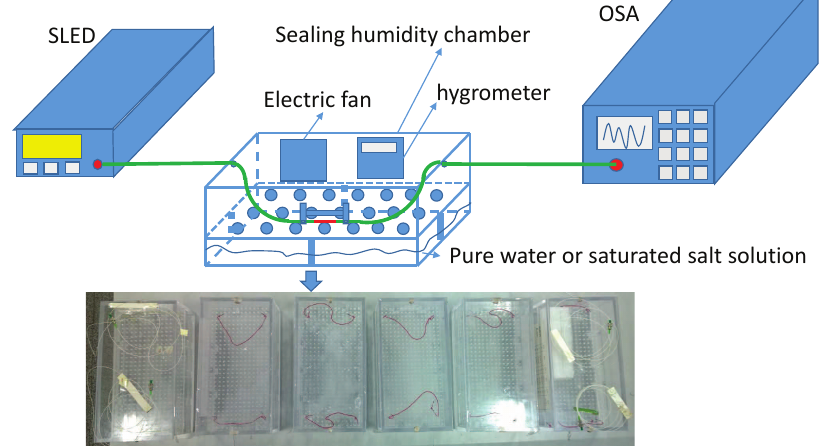
Figure 2. Schematic diagram of the experimental setup for RH measurement. OSA: optical spectrum analyzer; SLED: super luminescent